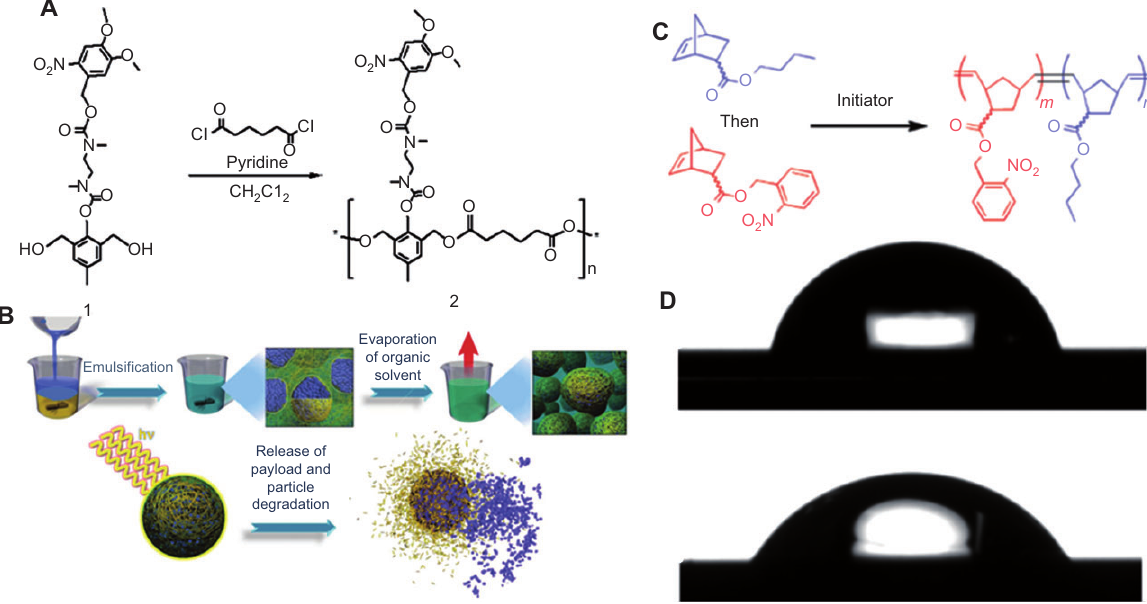
Figure 16 (A, B) Synthesis of light-responsive pendent-NBE polymer; an illustration of the formulation of nanoparticles, their degradation, and light-triggered release of their encapsulated Nile Red payload [104] . Adapted with permission from Ref. [104] . Copyright (2010) American Chemical Society. (C, D) ROMP synthesis of pendent-NBE copolymer; decrease of contact angle of water on a spun-cast thin fi lm from before irradiation (top) to after irradiation (bottom) [103] . Adapted with permission from Ref. [103] . Copyright (2011) American Chemical